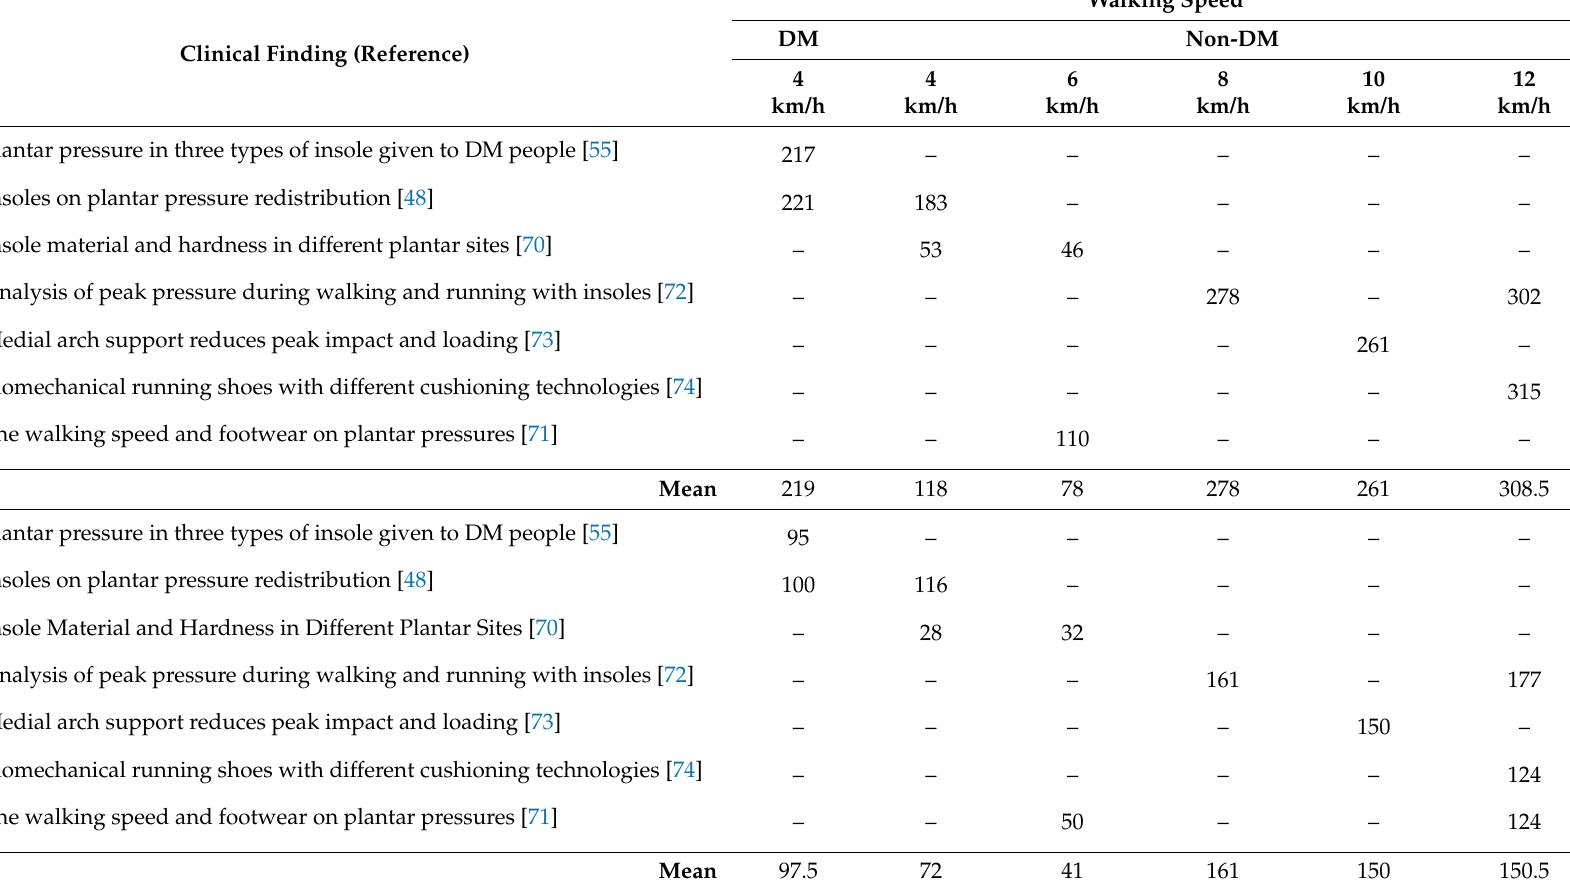
Table 1. The peak plantar pressure in preferred walking speed in people with DM and different walking speeds in non-DM people.